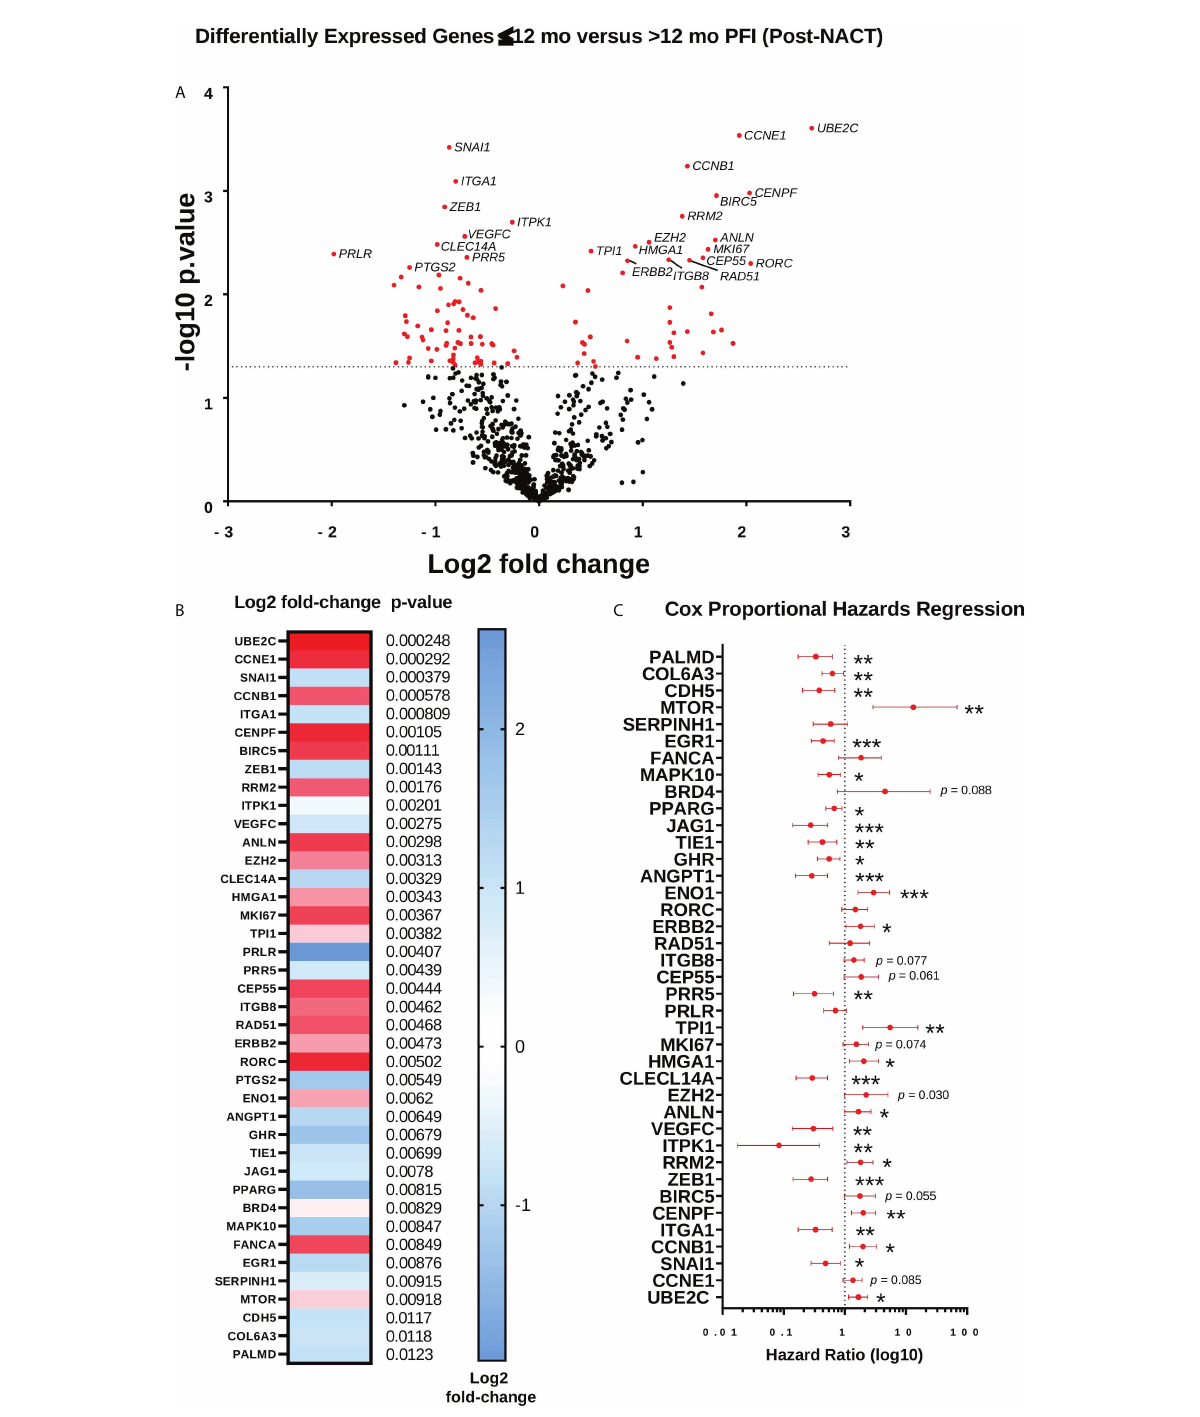
FIGURE 10 Differential expression of genes post-NACT in patients with longer platinum free interval (PFI). (A) Volcano plot showing differential expression of genes between patients with ≤ 12 mo PFI versus >12 mo PFI. (B) Top 40 differentially expressed genes between patients with ≤ 12 mo PFI versus >12 mo PFI. Heat map shows log2 fold-change, with p-value shown adjacent. No genes met Benjamini-Yekutieli adjusted p-value threshold. (C) Forest plot showing Cox proportional hazards regression of post-NACT gene expression and PFI. Log10 hazard ratios are indicated on the x- axis. Bars indicate 95% con fi dence interval. *p<0.05; **p<0.005;